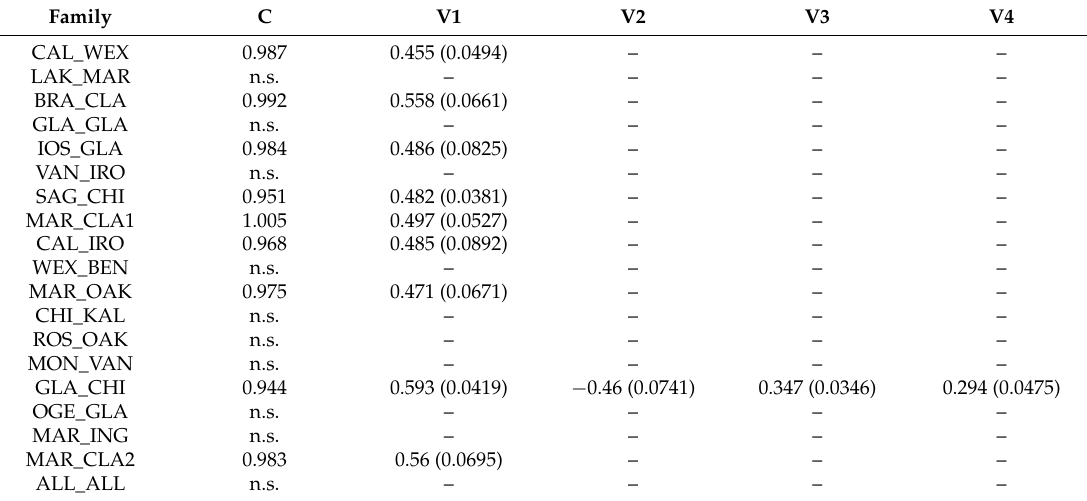
Table 2. Coefficients of regression models relating radial growth of hybrid aspen families to temperature variables. Climate variables (V) are identified in Figure 3.